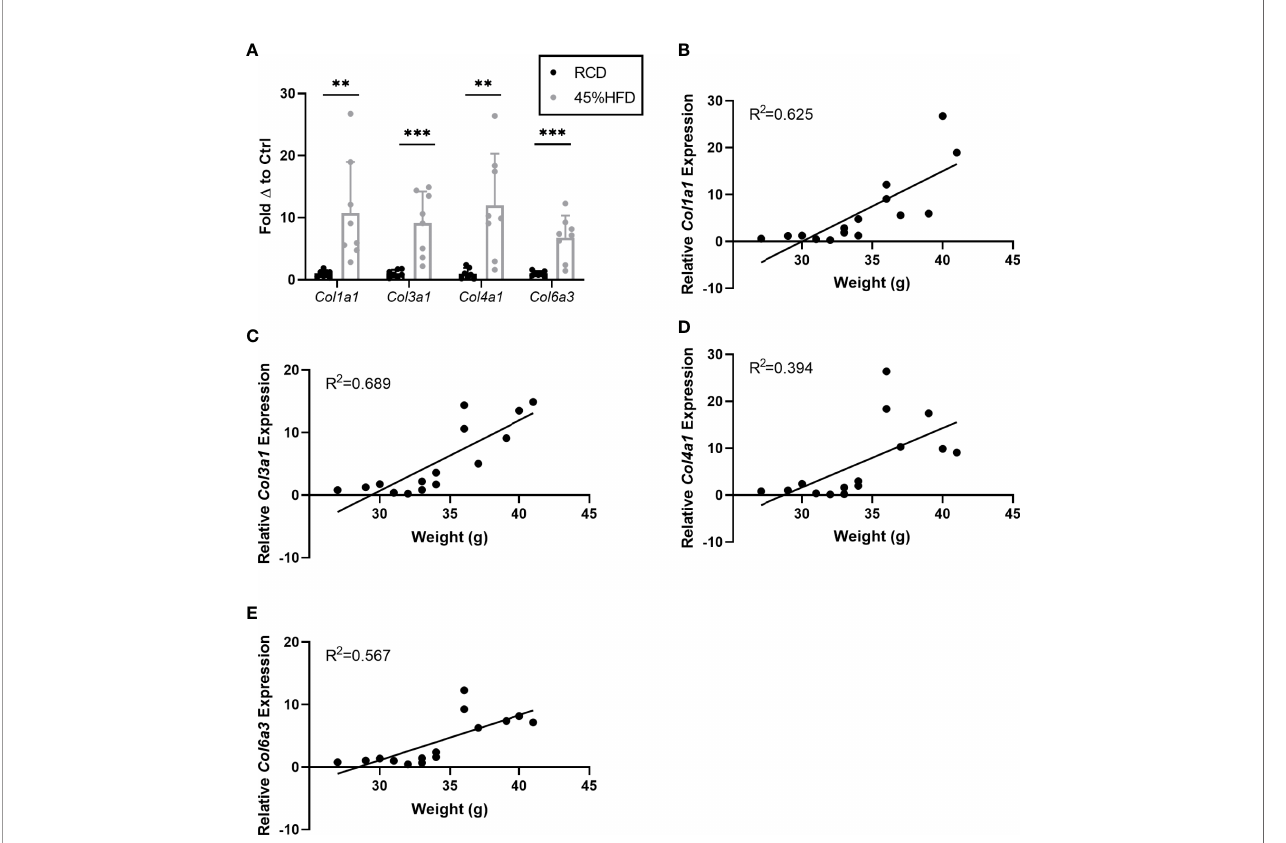
FIGURE 2 | Gene expression of collagen species in sWAT of HFD fed mice. (A) Collagen species mRNA expression in sWAT of mice after 8 weeks of dietary study normalized to the average of RCD control group. RCD (n=7), HFD (n=8). (**,***) indicates p < 0.01, 0.001), respectively. Data are Means ± SD. (B – E) Relative Col1a1 mRNA expression normalized to RCD group graphed against weight (grams) for each mouse in 8-week dietary study (n=15). Simple linear regression